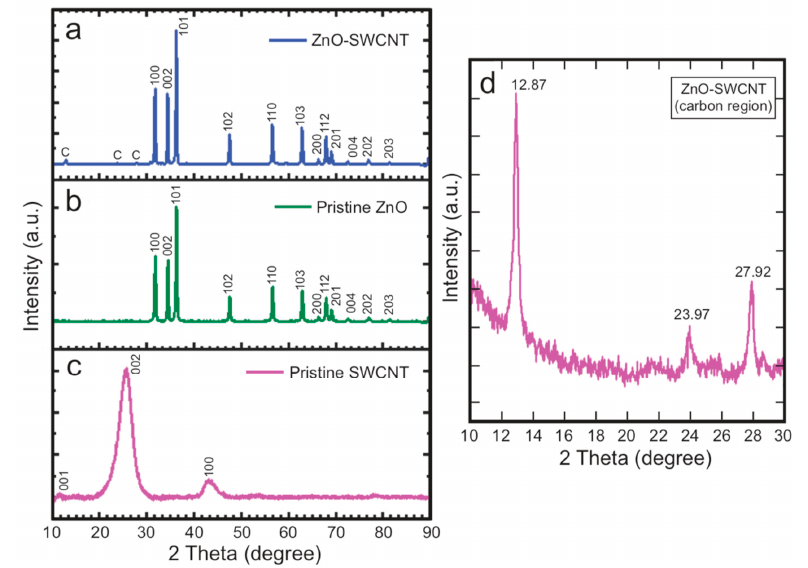
Figure 3. XRD patterns of ( a ) the ZnO–SWCNT nanocomposite, ( b ) the pristine ZnO, and ( c ) the pristine SWCNTs; ( d ) magnified peaks in the carbon portion of the XRD pattern of the nanocomposite.